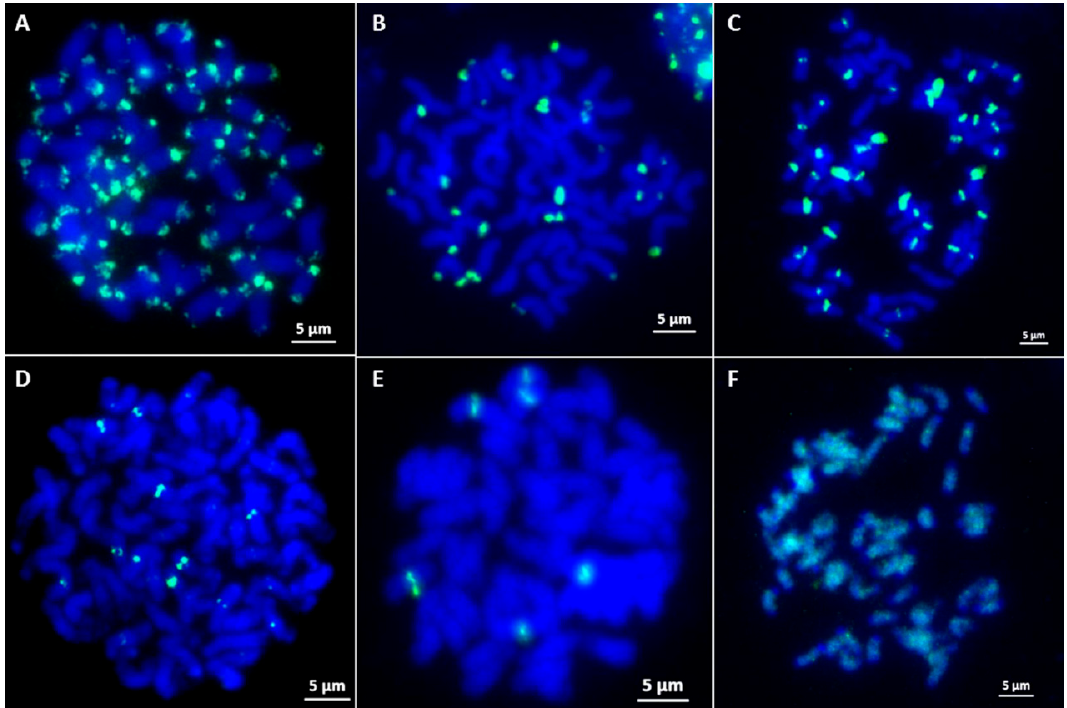
Figure 3. The FISH result of clones from SSH library. ( A ) The ends of most E. arundinaceus chromo- somes; ( B ) The ends of a part of E. arundinaceus chromosomes; ( C ) The centromeric region of most E. arundinaceus chromosomes; ( D ) The centromeric region of a part of E. arundinaceus chromosomes; ( E ) The centromeric region of six E. arundinaceus chromosomes; ( F ) Diffuse distribute on all E. arun- dinaceus chromosomes, except for the ends of E. arundinaceus chromosomes. Scale bars = 5 μ m.